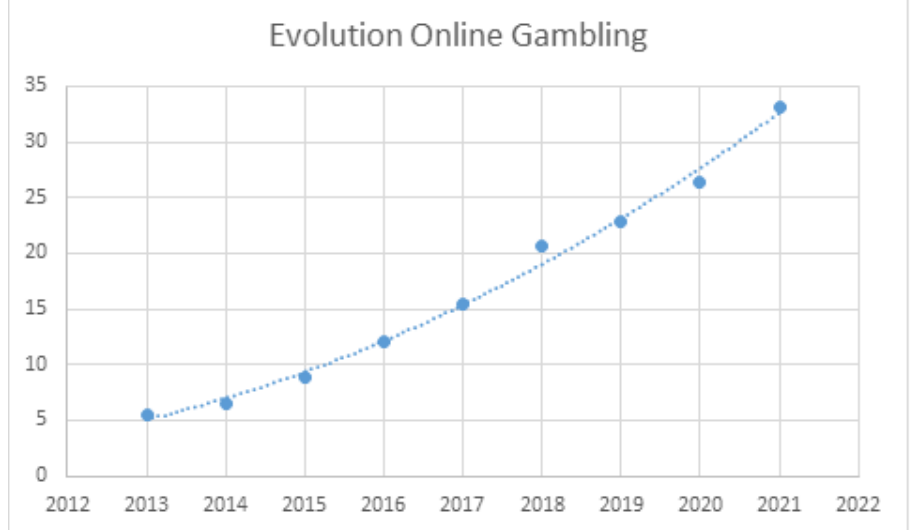
Figure 2. Evolution of online gambling (2013–2021) in Spain (data are billions of Euros).